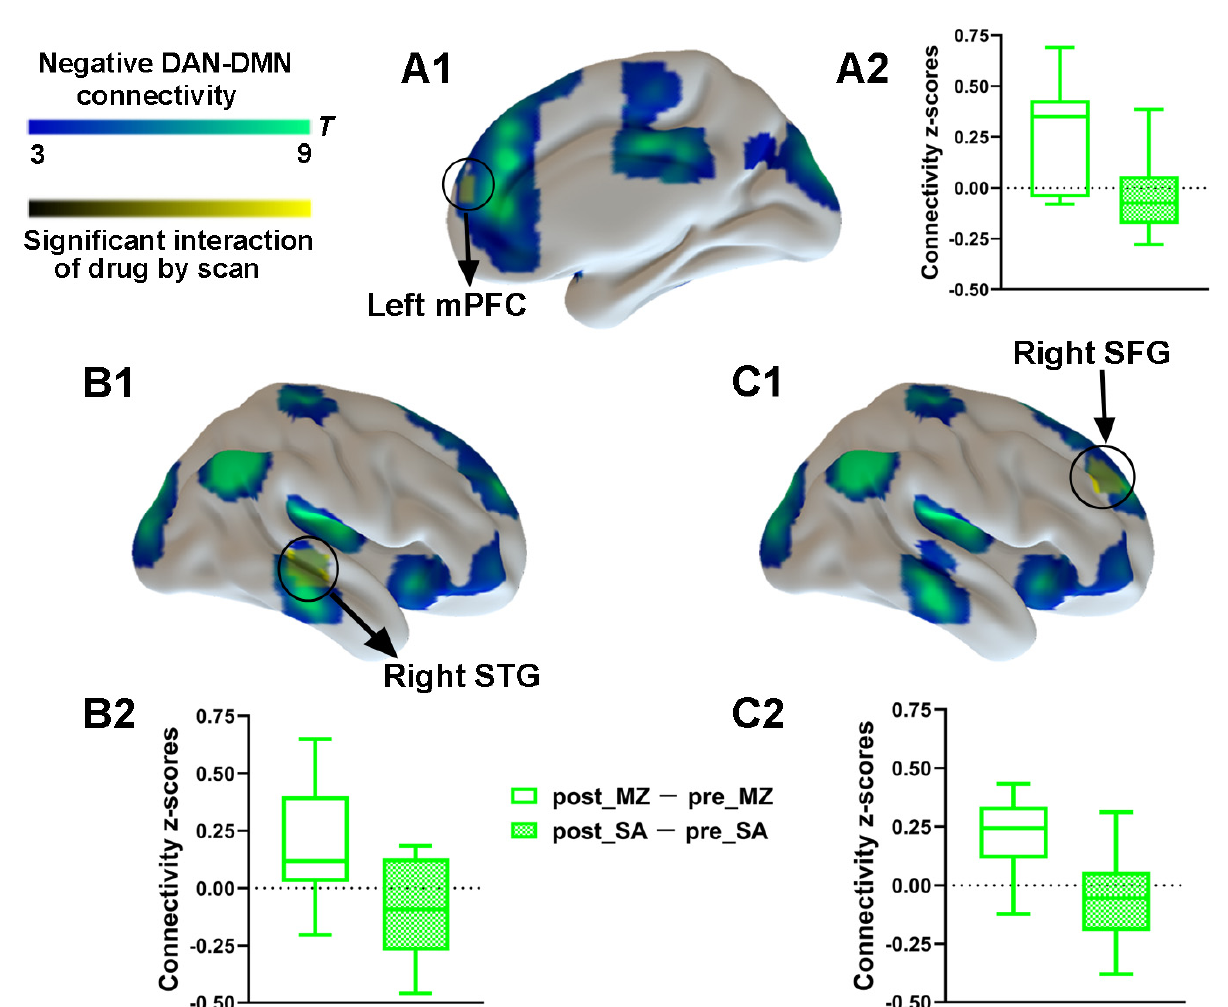
Figure 5. Spatial differences in functional connectivity between-network anticorrelations by midazolam injection. Two-way repeated-measures ANOVA revealed significantly decreased DAN–DMN anticorrelation (in yellow) by midazolam injection between regions predefined as pertaining to DAN and the left mPFC ( A1 ) and right STG ( B1 ) and right SFG ( C1 ). Significant results are overlaid on the spatial maps (shown in cold blues) of the DMN (cluster-level FWE correction). ( A2 ) Functional connectivity of the post_MZ-pre_MZ and the post_SA-pre_SA between left mPFC and DAN that showed significant interaction between drug and injection measurements among volunteers under each condition. ( B2 ) Functional connectivity of the post_MZ-pre_MZ and the post_SA-pre_SA between right STG and DAN that showed significant interaction between drug and injection measurements among volunteers under each condition. ( C2 ) Functional connectivity of the post_MZ-pre_MZ and the post_SA-pre_SA between right SFG and DAN that showed significant interaction between drug and injection measurements among volunteers under each condition. Boxplot whiskers indicate min and max. Box is defined by 25th percentile, median, and 75th percentile. Bars represent average functional connectivity strength ( z -values), and error bars indicate standard (SE) derived from the ANOVA test on the cluster that showed significant interaction between drug and injection measurements. Abbreviations: mPFC, medial prefrontal cortex; STG, superior temporal gyrus; SFG, superior frontal gyrus; DAN, dorsal attention network; DMN, default mode network; MZ, midazolam; SA, saline.